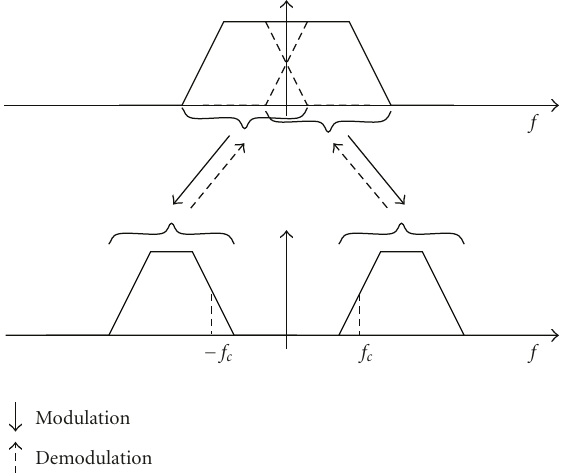
Figure 2: Vestigial side-band modulation and demodulation. The figure depicts the signals